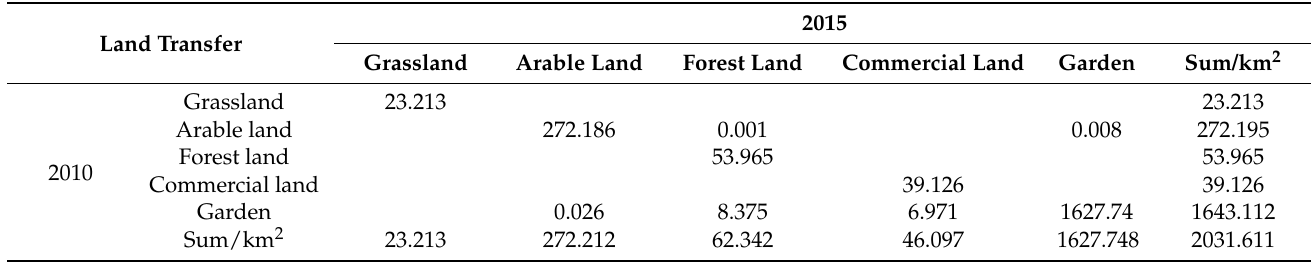
Table 5. Land use transfer matrix of